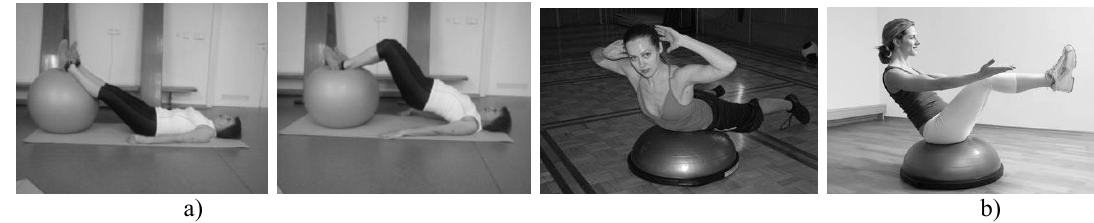
Fig. 1. Exercises on fit-ball (a) and on BOSY (b)